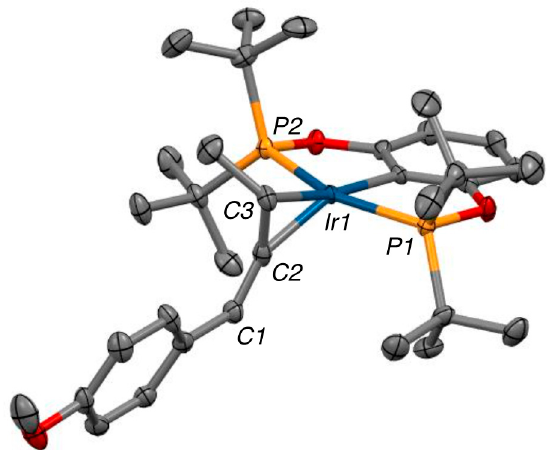
Figure 2. ORTEP diagram of 2b with 40% probability thermal ellipsoids. Key bond lengths (Å)